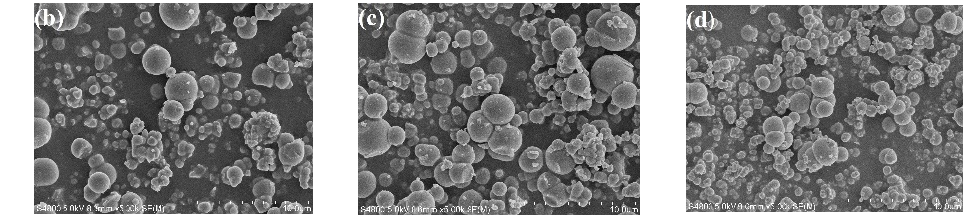
Figure 7. SEM images for ( a ) HSiW@UiO-66, ( b ) HSiW@ZrO 2 -300, ( c ) HSiW@ZrO 2 -400, and ( d ) HSiW@ZrO 2 -500. (Adapted with permission from Ref. [62]. Copyright 2021, open access from Royal Society of Chemistry.)